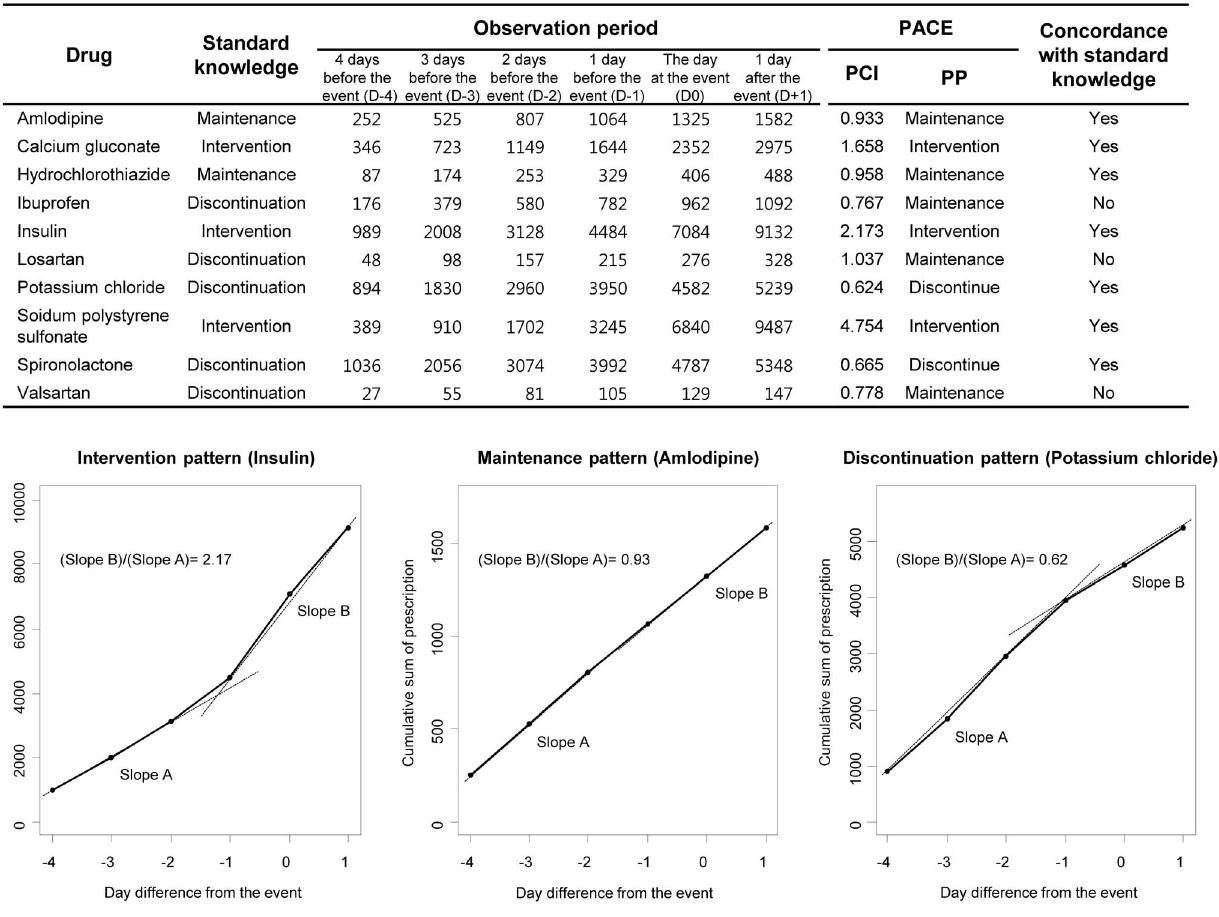
Figure 2. Prescription pattern for hyperkalemia measured by the PACE algorithm. Prescription patterns were categorized into three types based on the prescription change index (PCI): intervention pattern (PCI . 1.500, bottom left), maintenance pattern (0.667 , PCI # 1.500, bottom center), and discontinuation pattern (PCI # 0.667, bottom right). Prescribing of calcium gluconate, insulin, and sodium polystyrene sulfonate increased after the occurrence of an event. Potassium chloride and spironolactone showed the discontinuation pattern. Amlodipine, hydrochlorothiazide, ibuprofen, losartan, and valsartan were maintained regardless of event occurrence (maintenance pattern). D-4, D-2, and D-1 represent 4, 2, and 1 day(s) before the event, respectively; D0 represents the day on which the event occurred; D + 1 represents 1 day after the event.